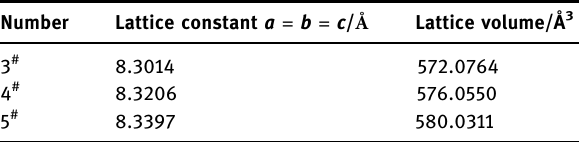
Table 4: Lattice parameters of the product Fe 3 O 4 after the first